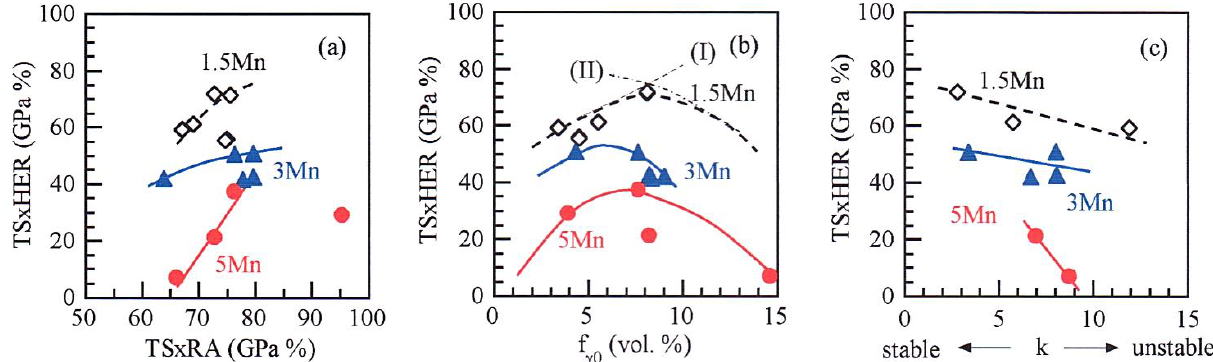
Figure 15. Relationships between TS × HER and ( a ) TS × RA, ( b ) initial retained austenite fraction ( f γ 0 ), and ( c ) strain- induced transformation factor ( k ) in the 1.5Mn ( ◇ ), 3Mn ( ▲ ), and 5Mn ( ● ) steels. The IT temperatures are between M s and M f − 100 C. Dashed lines I and II in ( b ) represent positive and negative f γ 0 dependences of TS × HER, respectively.